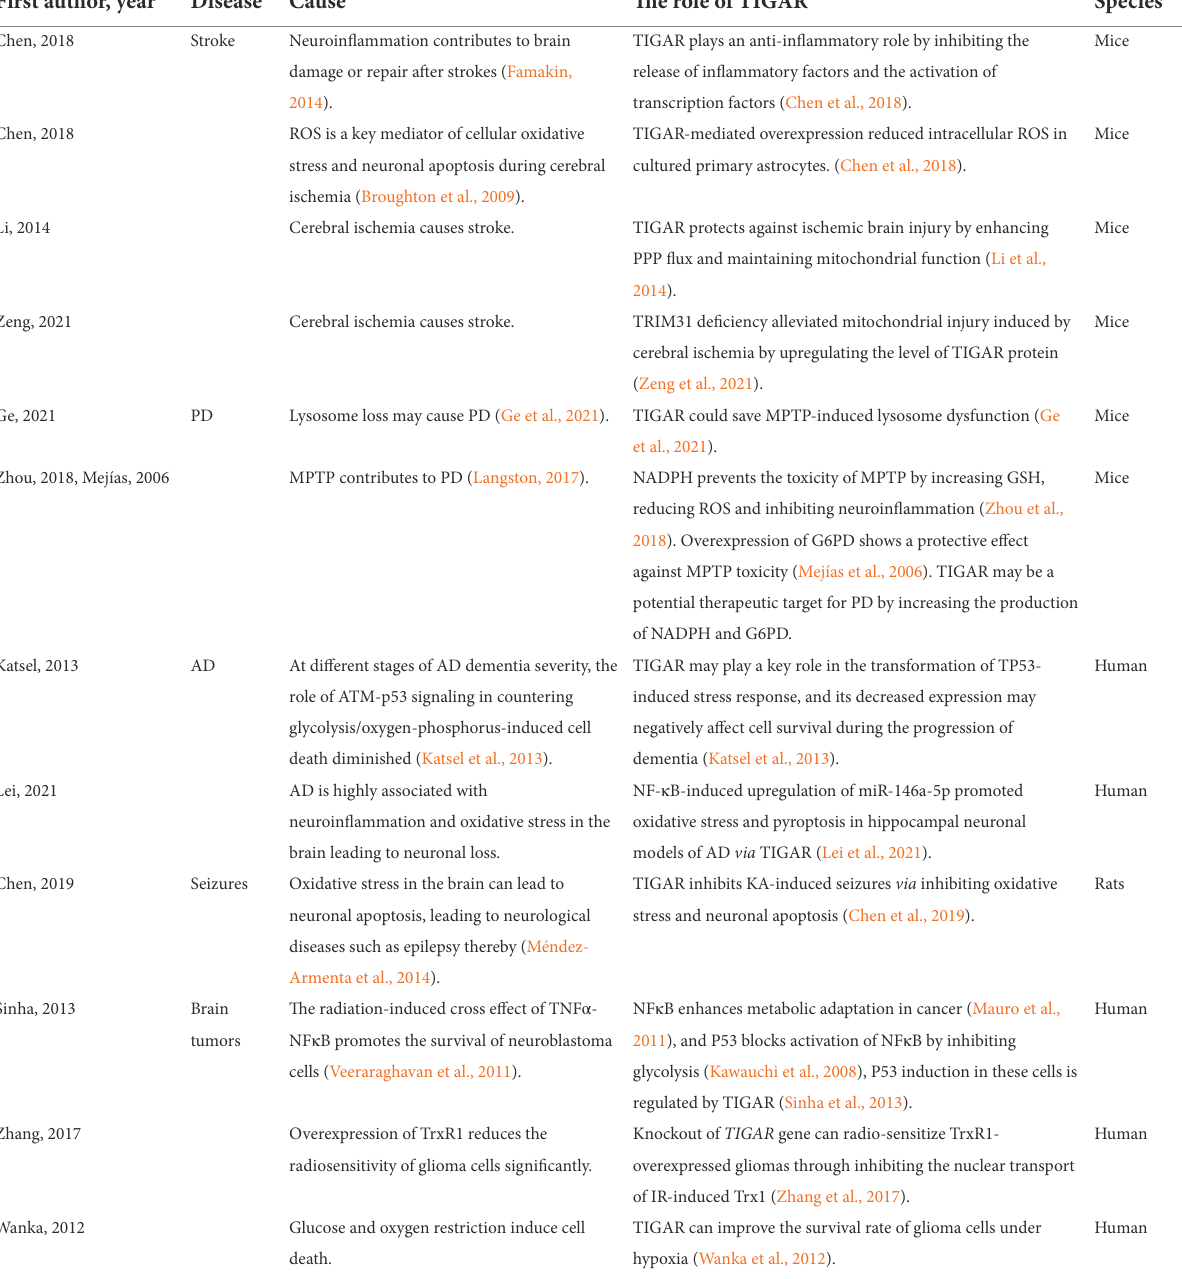
TABLE 3 The role of TIGAR in nervous system